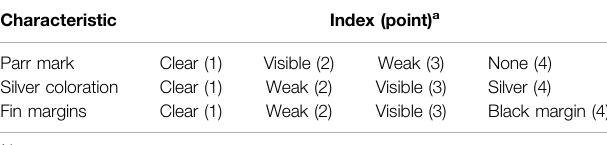
TABLE 1 | Three characteristics for smolt index